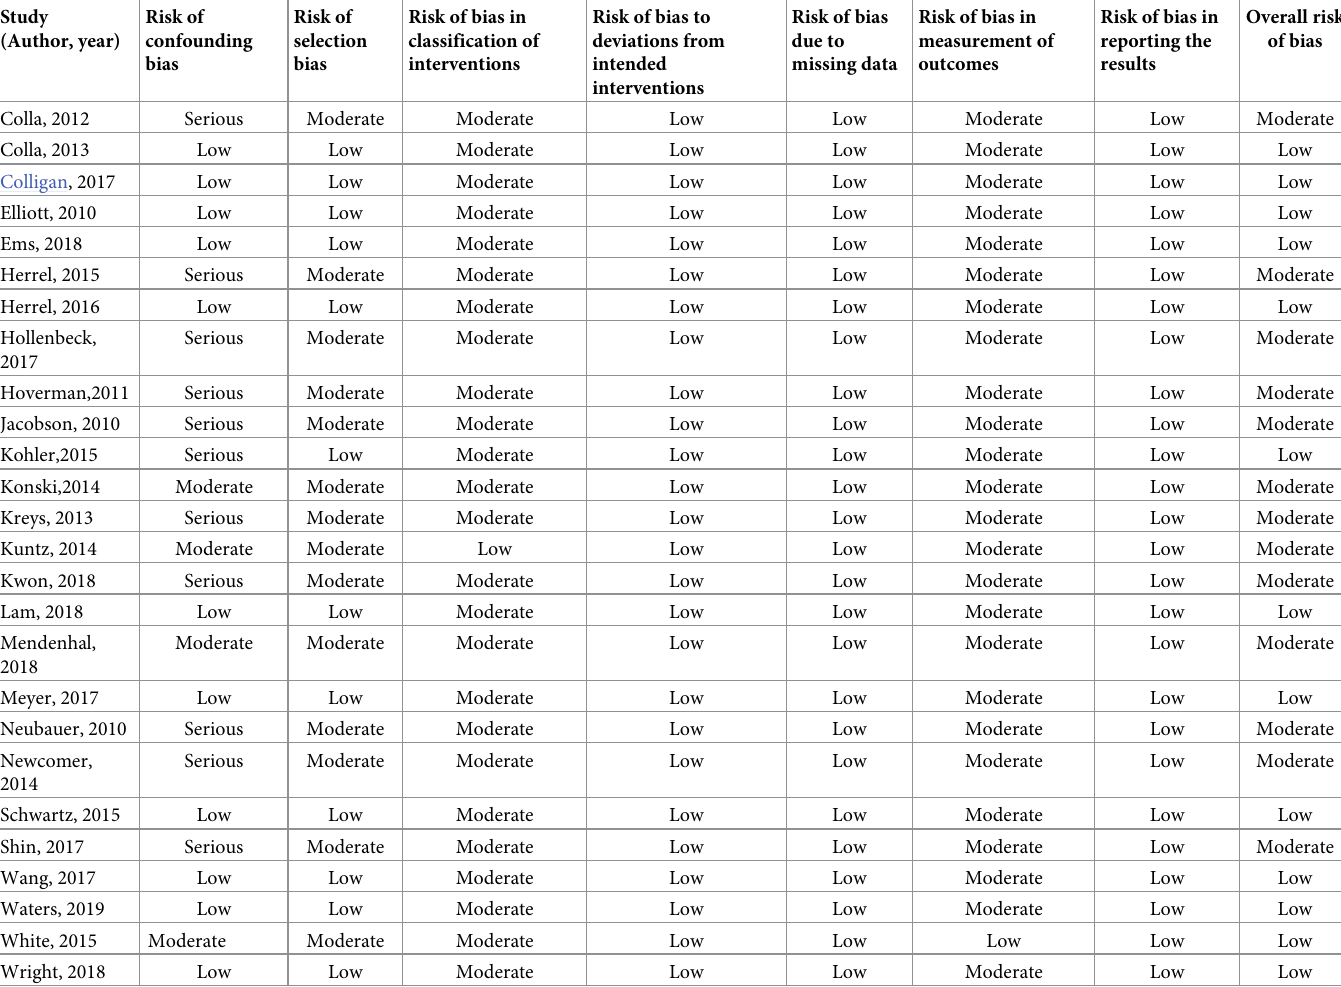
Table 4. Risk of bias assessment using ROBINS-I tool for non-interventional